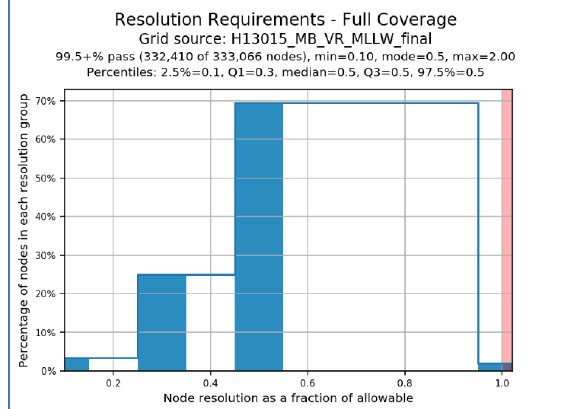
Figure 9. Grid QA output for resolution. Created only for variable-resolution surfaces, the histogram helps to identify the percentage of nodes that have a node resolution as a fraction of the allowable resolution at that depth. Anything over 1.0 (in red) does not pass the uncertainty requirements.